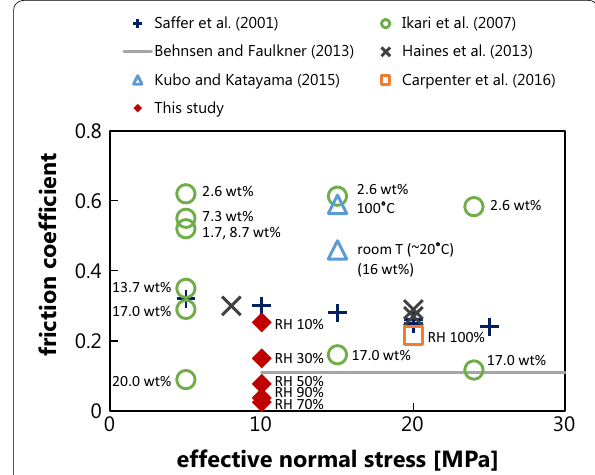
Fig. 7 Comparison of our experimental data with previous experi- mental studies of Ca-montmorillonite at effective normal stresses of 5–25 MPa, temperatures up to 100 °C, and loading velocities up to 10 µm/s. The note near the symbols show each water con- tent or experimental condition. The sample of Saffer et al. (2001) has ~ 11 wt% water. Behnsen and Faulkner (2013) carried out experi- ments under water-saturated condition, and Haines et al. (2013) conducted at room temperature and